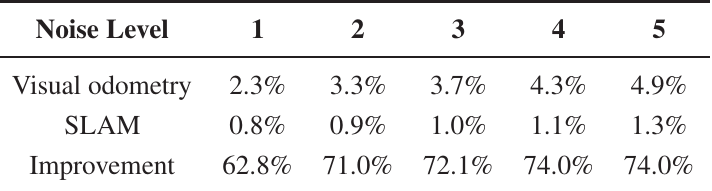
Table 2. Comparison of errors in visual odometry and SLAM using a keyframe separation of 30, EKF update and filtered images. Errors are expressed as the percentage of error with respect to the trajectory